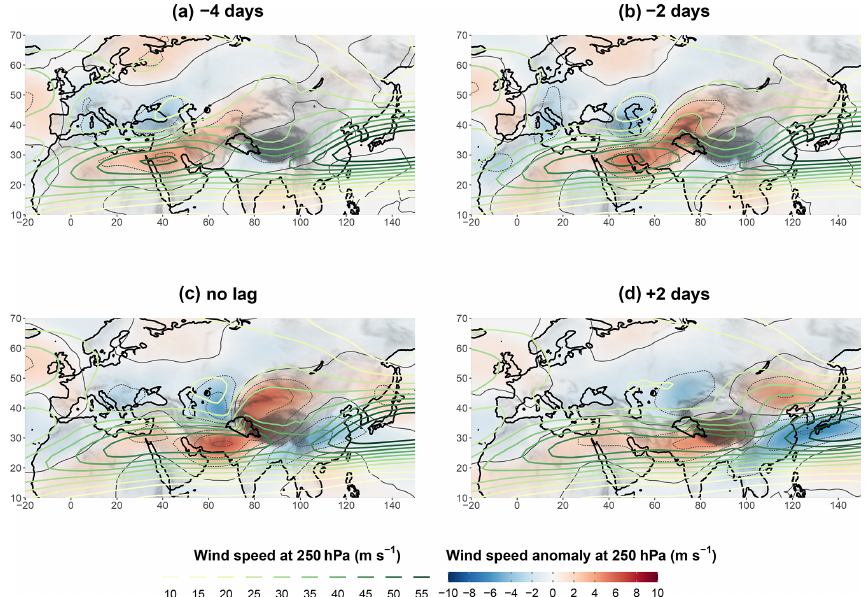
Figure 5. Composite maps of wind speed (thick contour lines) and wind speed anomaly (colour shading, thin contour lines every 2ms − 1 ) at 250hPa, based, for panel (c) , on the same selection of the 10% highest UV700 as in Fig. 3. For panels (a) , (b) , and (c) , a 4d lead, a 2d lead, and a 2d lag, respectively, is applied to the fields. Non-significant anomalies at the 95% level are shown in